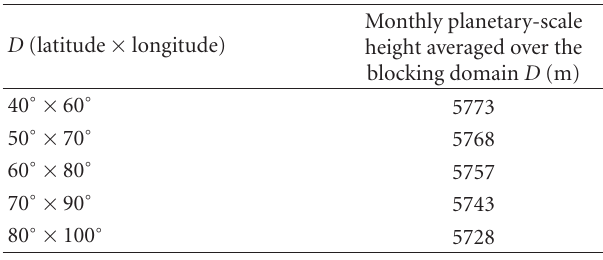
Table 1: Assessment of the blocking domain size variation, for the 500hPa monthly average planetary-scale height, during August 2004, for the selected blocking